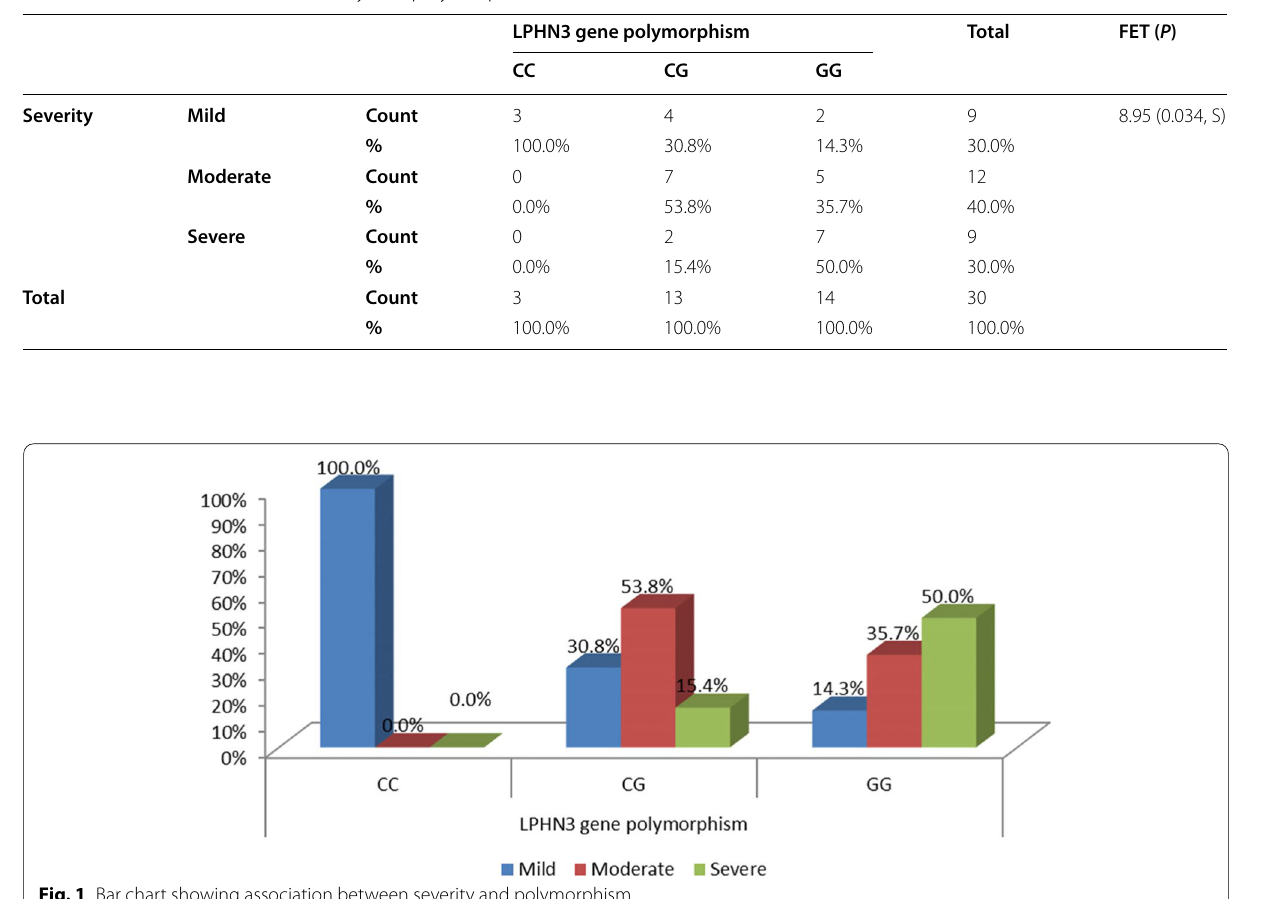
Table 4 Association between severity and polymorphism